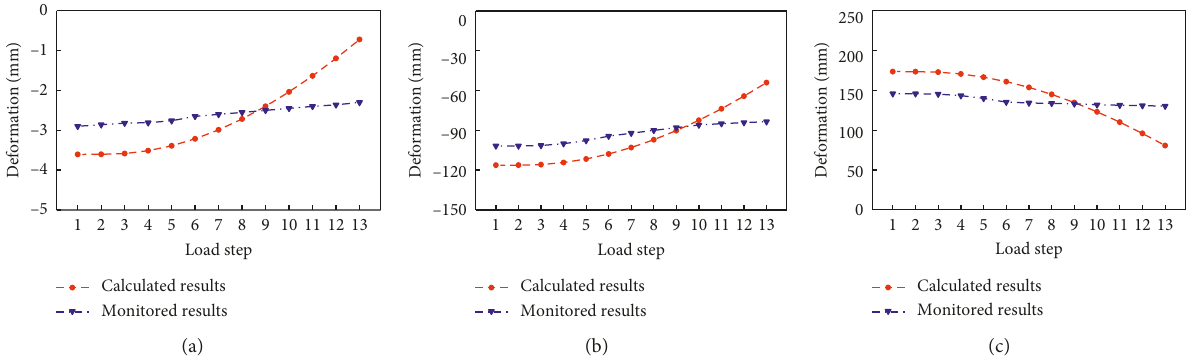
Figure 15: Comparison of calculated and monitored results of deformation of No. 2 joint. (a) X direction. (b) Y direction. (c) Z direction.